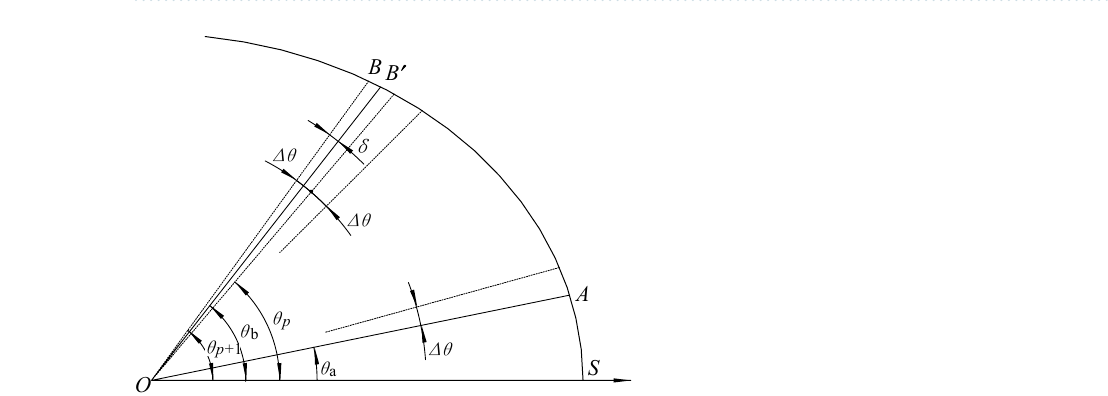
Figure 2. Structure diagram of the CAD system.